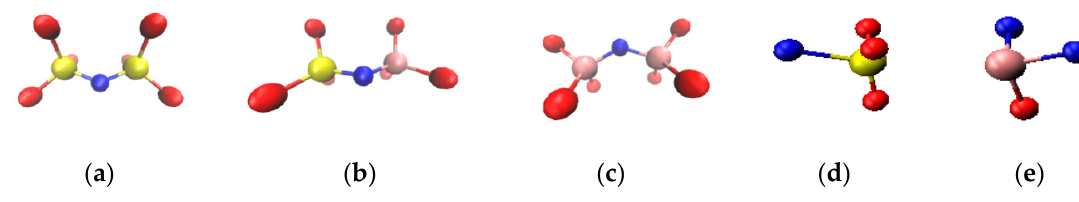
Figure 7. Bonding state diagram of the F ion when CaF 2 content is 9% ( a ) Si–F–Si structure; ( b ) Si–F– Al structure; ( c ) Al–F–Al structure; ( d ) Al–F structure; and ( e ) Si–F structure. structure; ( c ) Al–F–Al structure; ( d ) Al–F structure; and ( e ) Si–F